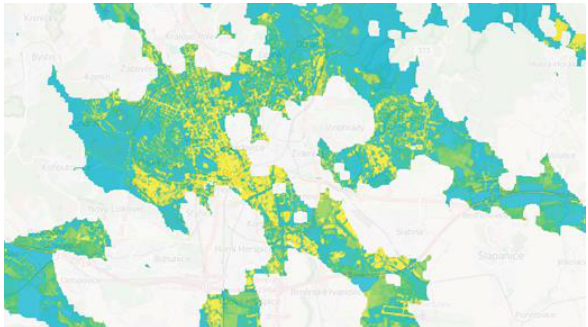
Figure 2. Trajectory of a tractor at the Tršická zemědělská farm (the Czech Republic) during one day as recorded by a GNSS receiver. Various colours of trajectory were used to distinguish the amount of fuel used per hour (green means consumption up to 25 litres per hour while red means consumption between 26 and 56 litres per